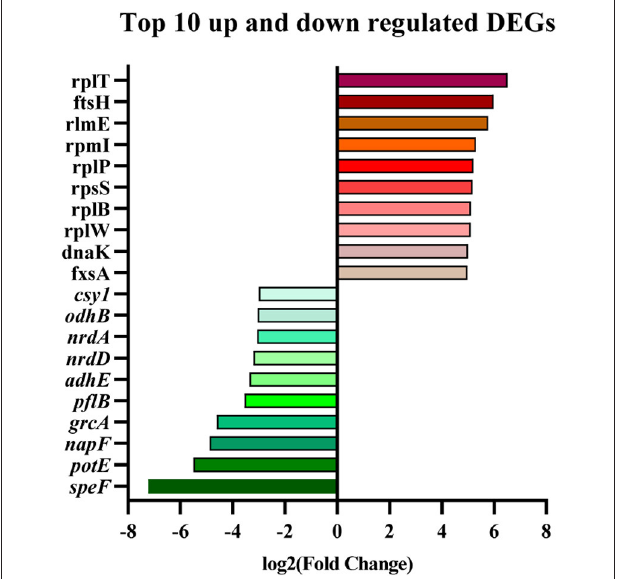
FIGURE 6 | Top 10 up and down regulated DEGs screened from Pm3/Pm64.